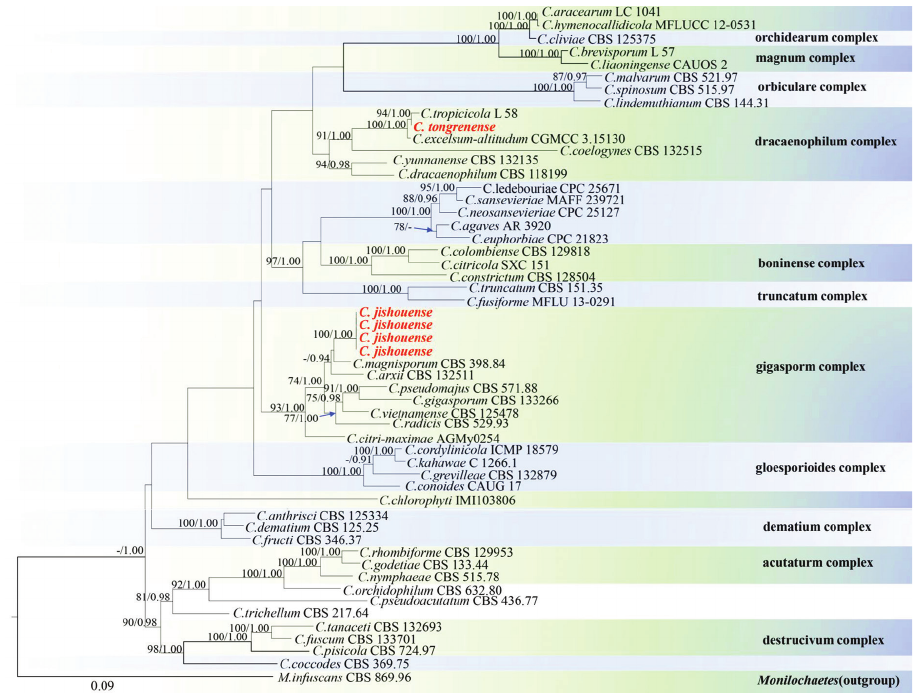
Figure 1. Phylogram generated from Maximum Likelihood (RAxML) analysis based on combined ITS, ACT, TUB2 and GAPDH DNA sequence data of Colletotrichum . Bayesian Posterior Probabilities (BSPP) greater than 0.90 and Maximum Likelihood Bootstrap Support values (MLBS) greater than 70% are shown above branches. New isolates are in red. The tree is rooted with Monilochaetes infuscans CBS